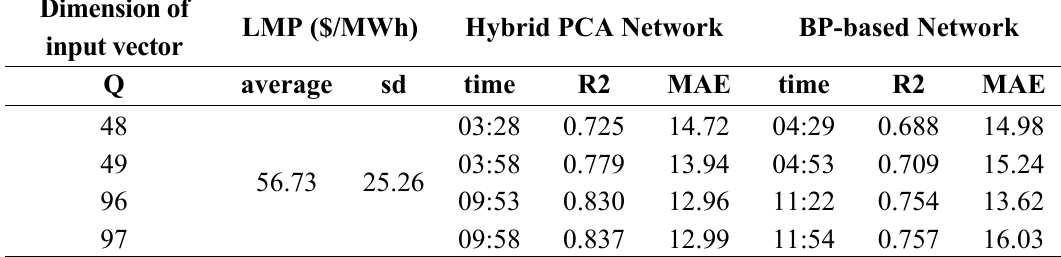
Table 8. Performance comparison between the proposed hybrid PCA and BP-based neural network (Byberry, winter).